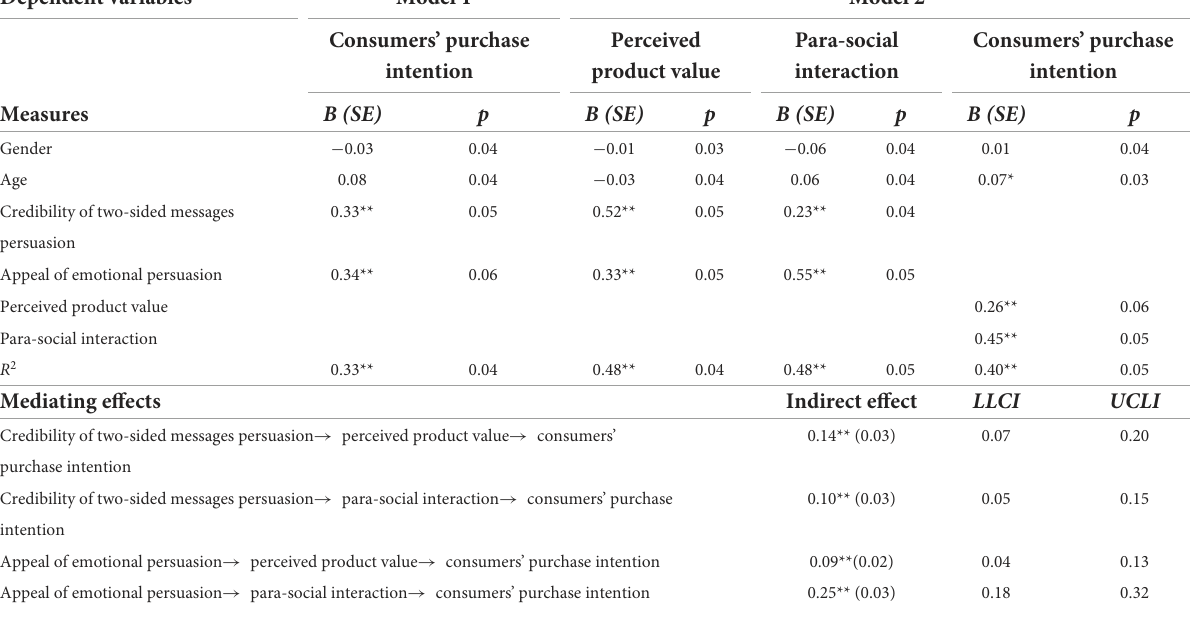
TABLE 3 Path analysis results of the direct and indirect effects ( N =